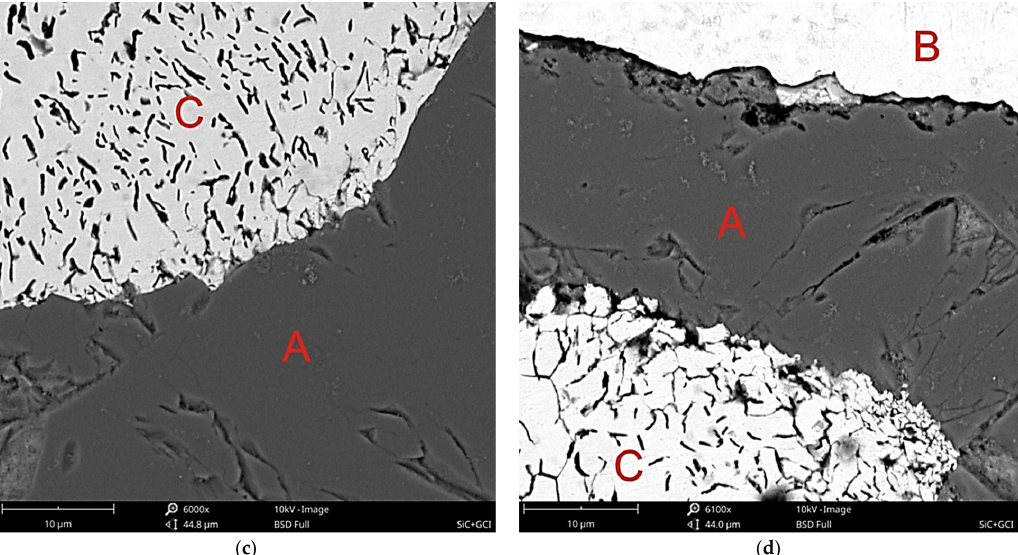
Figure 6. Composite microstructure of gray cast iron– β -SiC in the area of the matrix contact with the reinforcement, SEM; ( a ) mag. 500×; ( b ) mag. 3000×; ( c ) mag. 6000×; ( d ) mag. 6100×, nonetched sample; A— β -SiC reinforcement; B—metallic matrix (gray cast iron); C—transition zone 1.